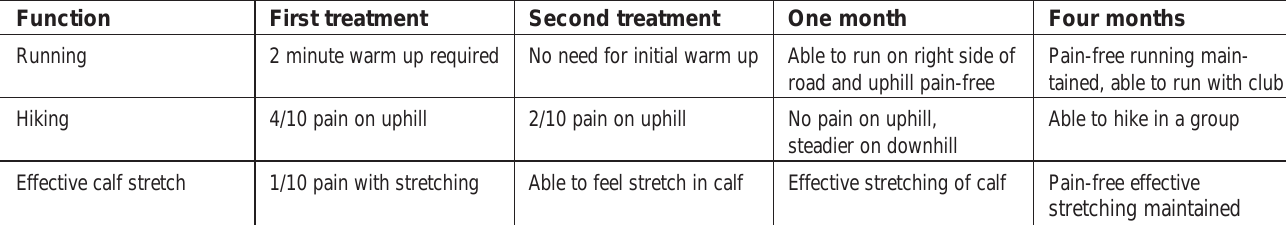
Table 5: Functional improvements as adapted from the Patient-Specific Functional